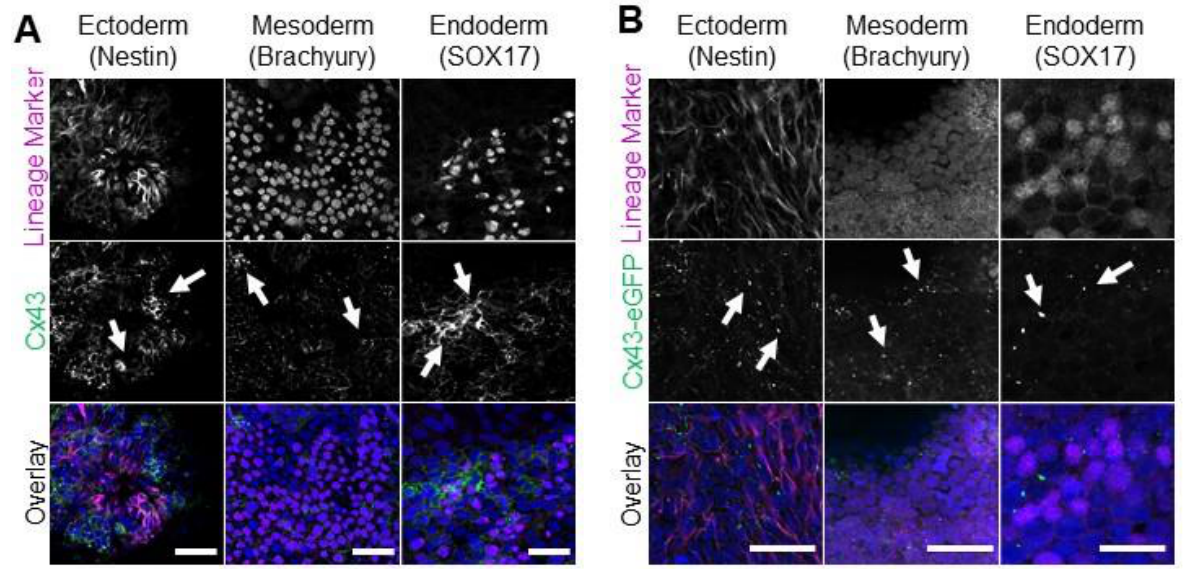
Figure 4. Control and Cx43-eGFP iPSCs spontaneously differentiate into cells from all three germ lineages. Representative immunofluorescence confocal micrographs demonstrating Cx43 or Cx43-eGFP (green) localization in control ( A ) or Cx43- eGFP reporter ( B ) iPSCs that underwent spontaneous differentiation into cells of each germ lineage: ectoderm (Nestin, purple), mesoderm (Brachyury, purple), or endoderm (SOX17, purple). Nuclei (Hoechst, blue). Cx43 forms large puncta (white arrows) at the cell surface indicative of gap junction plaques. Scale bars = 50